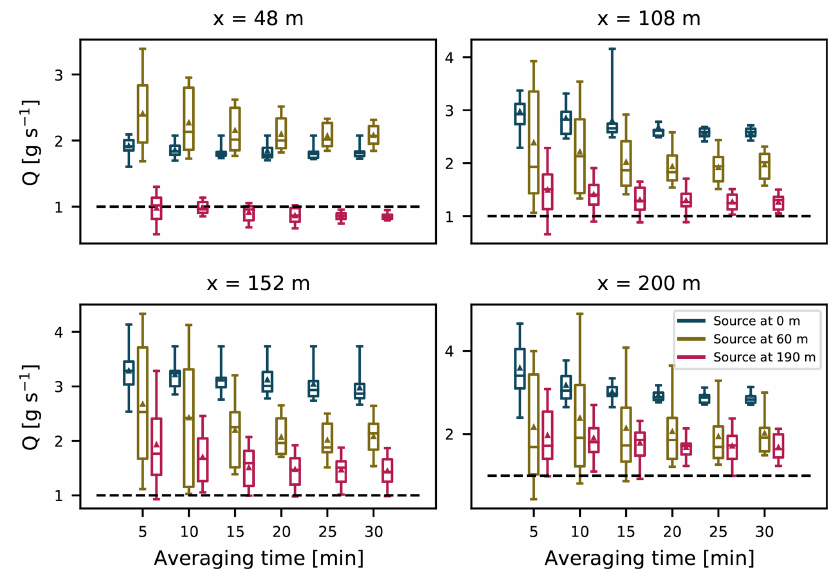
Figure 10. Source estimation using OTM 33A for four different distances from the source and for different averaging times. Boxes show the interquartile range, while the whiskers span from the 5th to 95th percentile of the data and show the mean and median. The dashed lines refer to the true source strength used in the LES.